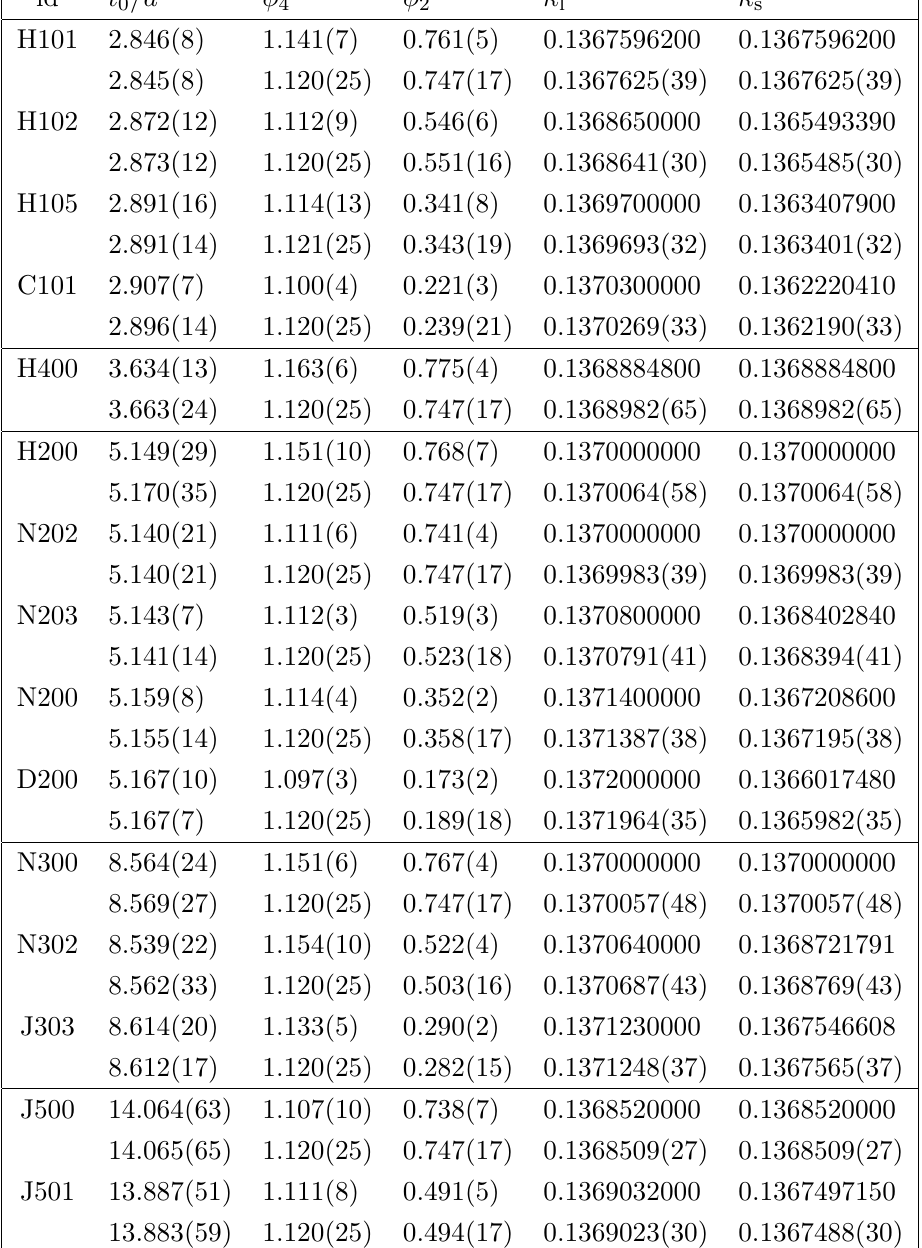
Table 4 . Overview of the results for the gluonic quantity t 0 /a 2 as well as the combinations φ 4 and φ 2 defined in eqs. (3.1) and (3.3) from pion and kaon masses, together with the associated hopping parameters. For every gauge field configuration ensemble we list the numbers before the quark mass shift (see section 3) in the rows with labels ‘id’ and the corresponding ones after the shift to φ phys in the rows without